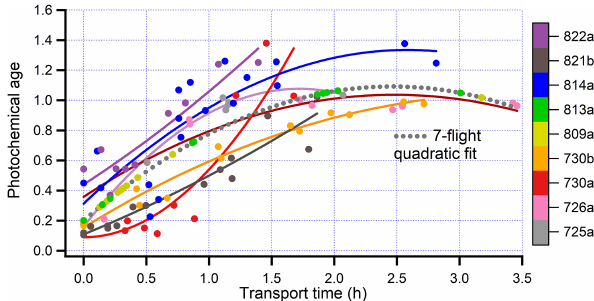
Figure 2. Comparison of photochemical age, − Log 10 (NO x / NO y ), with downwind transport time calculated from distance and aircraft wind measurements. Each colored point is a transect of a flight iden- tified in the legend. Solid lines are quadratic fits to each of seven flights. A quadratic fit for the combined seven-flight data set is used to estimate photochemical age for flights 809a and 813a, which are missing NO y